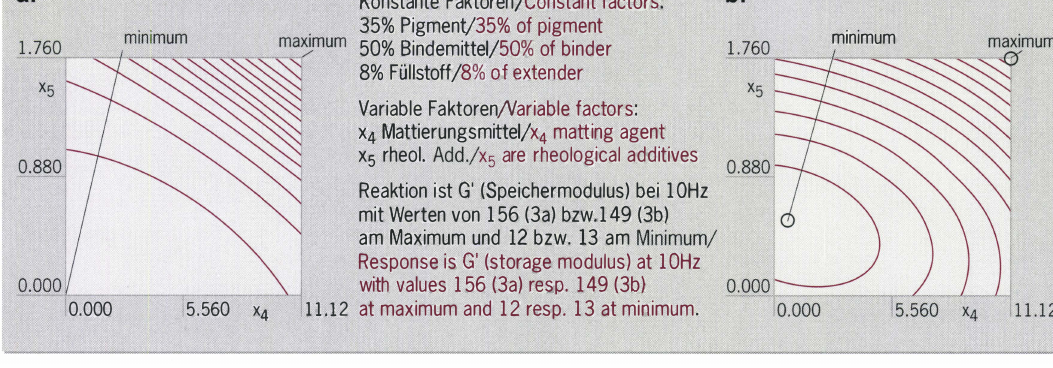
Fig. 3: Two dimensional cross­ section of neural network (a} and polynominal model (b) for storage modulus G' at 10Hz. The most suitable polynominal model was linear equation with some mixed and quadratic